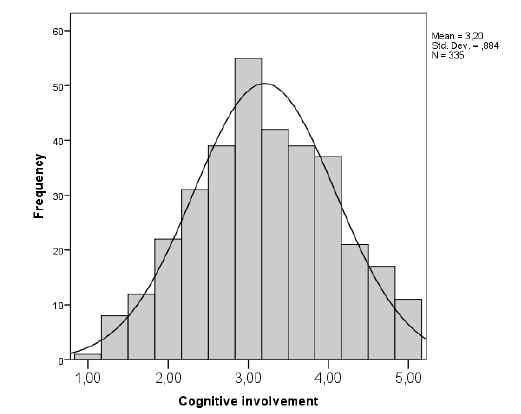
Fig. 2 – Distribution of a cognitive involvement factor Source: own